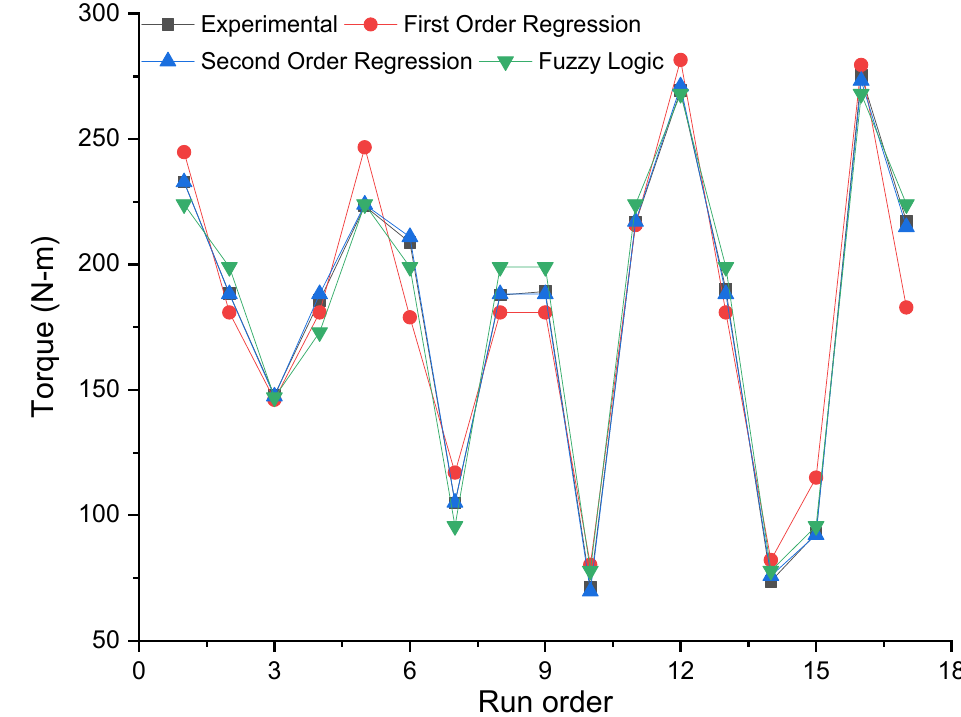
Figure 16. Comparison of experimental and predicted values of torque.